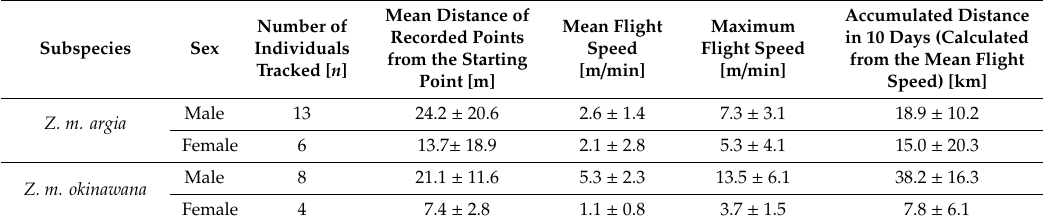
Table 1. Dispersal-related traits in the two subspecies of Z. maha